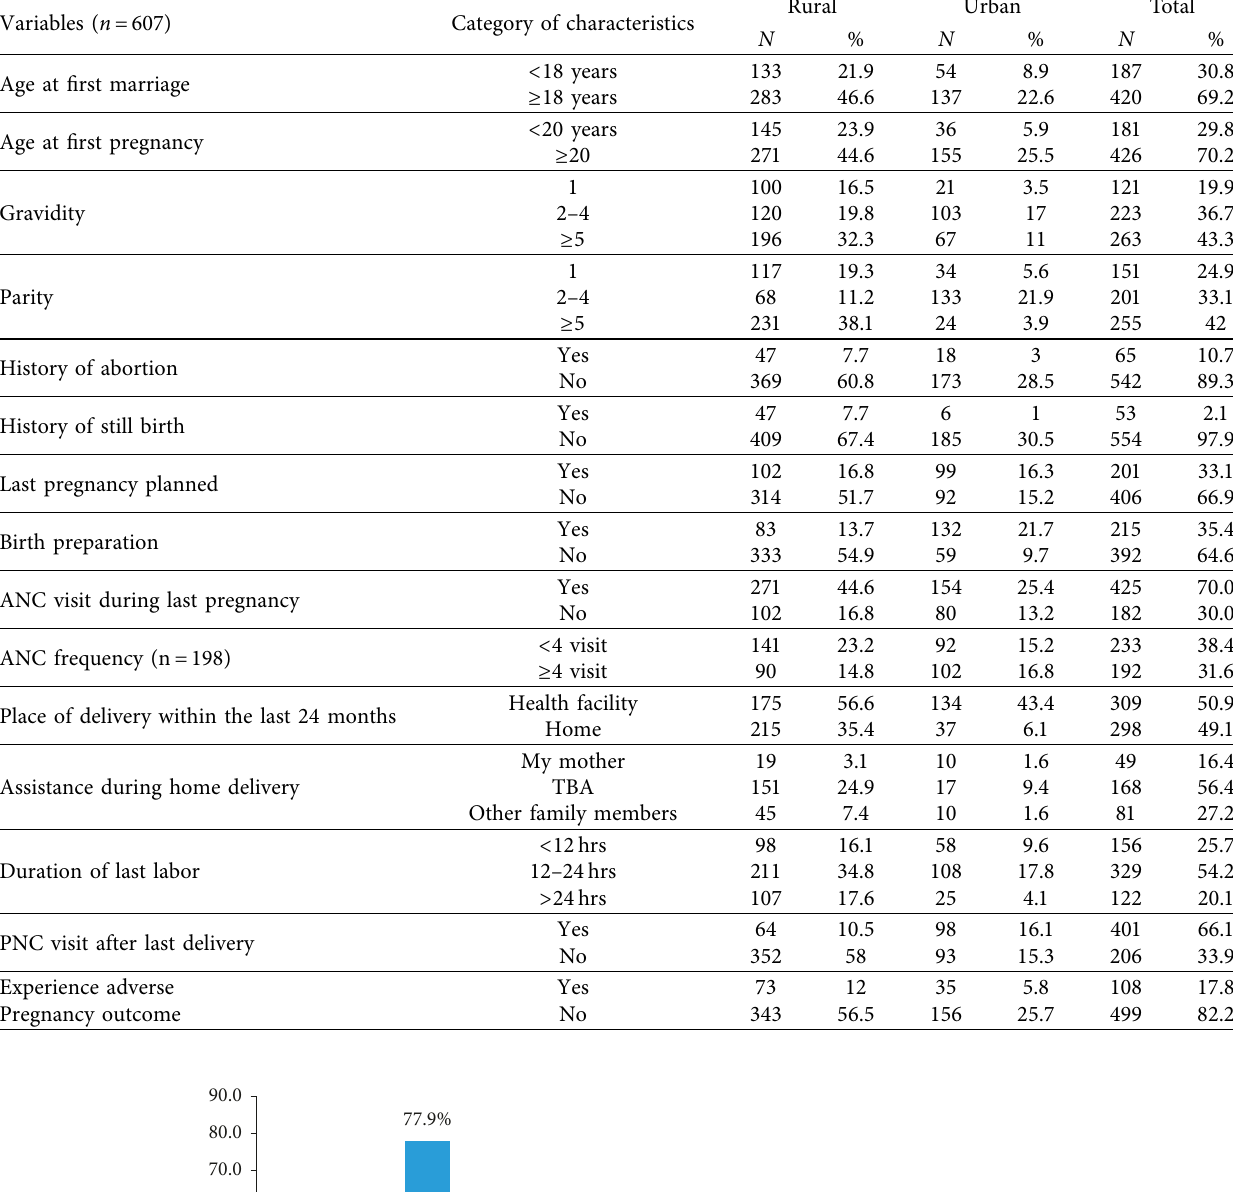
Table 2: Last obstetric characteristics of respondents by residential area, Kembata Tembaro zone, Southern Ethiopia, 2020. Variables ( n 607) (cid:31)